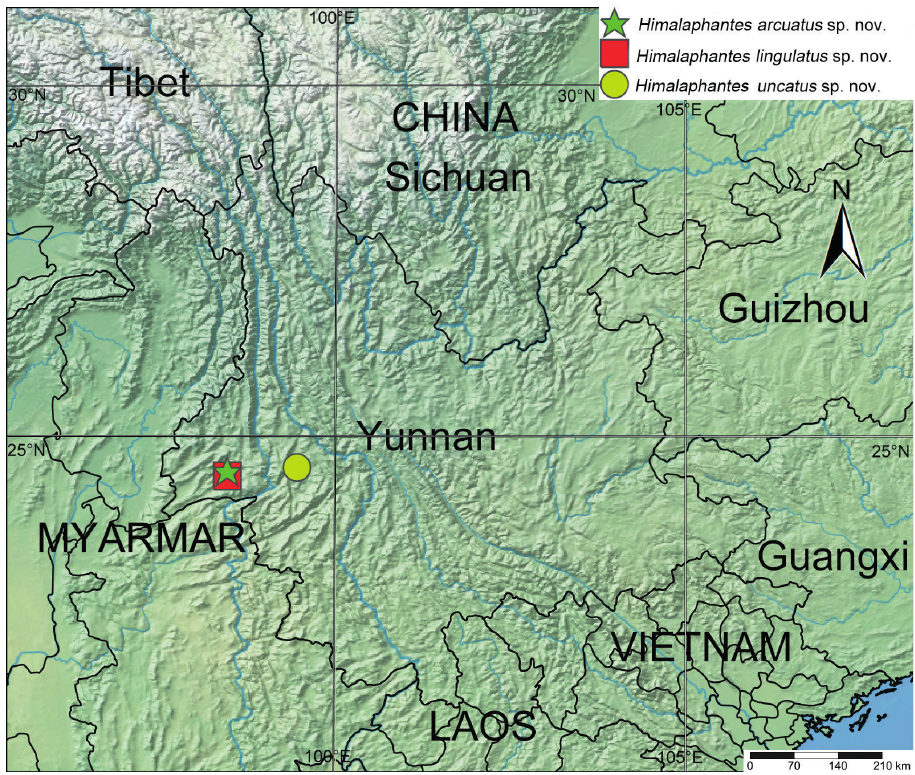
Figure 10. Type localities of Himalaphantes arcuatus sp. nov., Himalaphantes lingulatus sp. nov. and Himalaphantes uncatus sp.